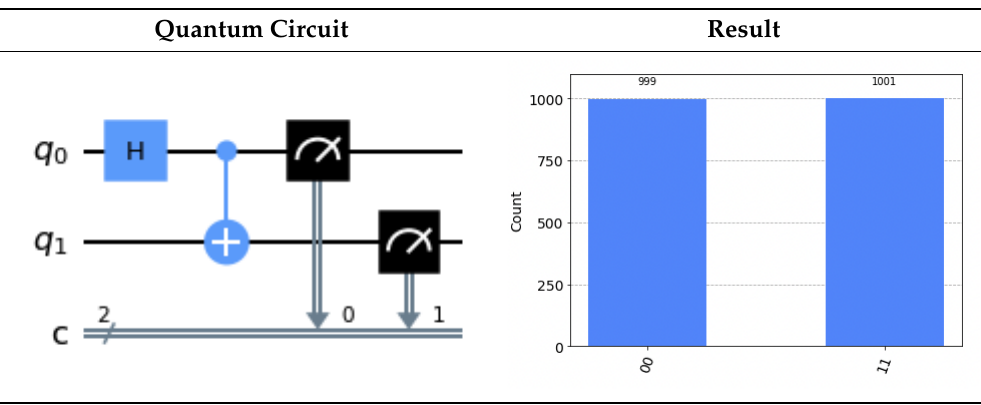
Table 3. A quantum circuit producing an entangled